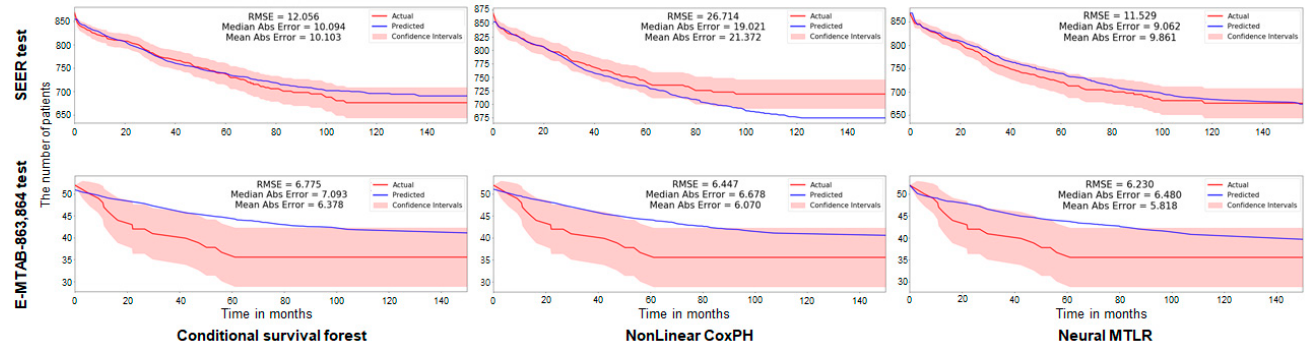
Figure 2. Internal and external validations of three developed models for disease-specific survival in mucinous colorectal cancer. The model shows reasonable discrimination in SEER database and arrayexpress datasets. RMSE, root mean square error.